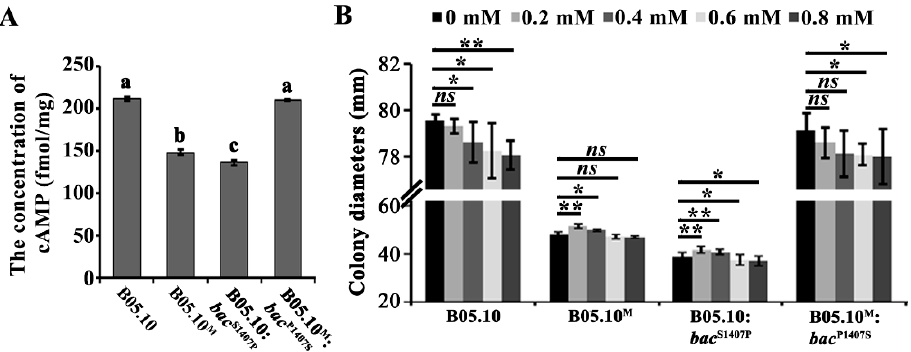
Figure 5. The S1407P mutation in bac affected intracellular cyclic AMP (cAMP) contents. ( A ) Intracellular levels of cAMP in the B05.10, B05.10 M , B05.10: bac S1407P , and B05.10 M : bac P1407S after incubation on CM for 3 days under light conditions. Di ff erent letters on the columns indicate significant di ff erences ( p < 0.05). ( B ) The colony diameters of the above strains on CM medium with and without exogenous cAMP (the final concentrations were from 0 to 0.8 mM) were measured. Single and double asterisks above the bars indicate significant di ff erences at p < 0.05 (*) and p < 0.01 (**), respectively; ns indicates no significant di ff erence. Student’s t -test was